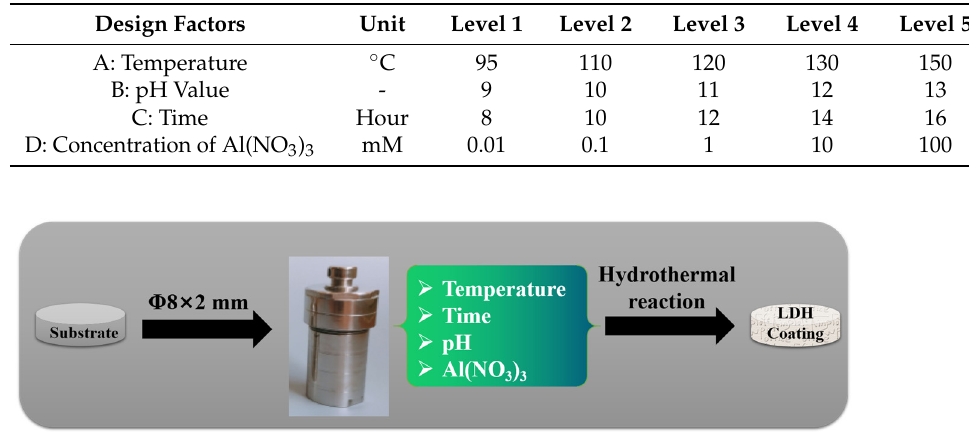
Figure 1. Schematic illustration of the experiment. Table 1. Factor level in orthogonal experiments.